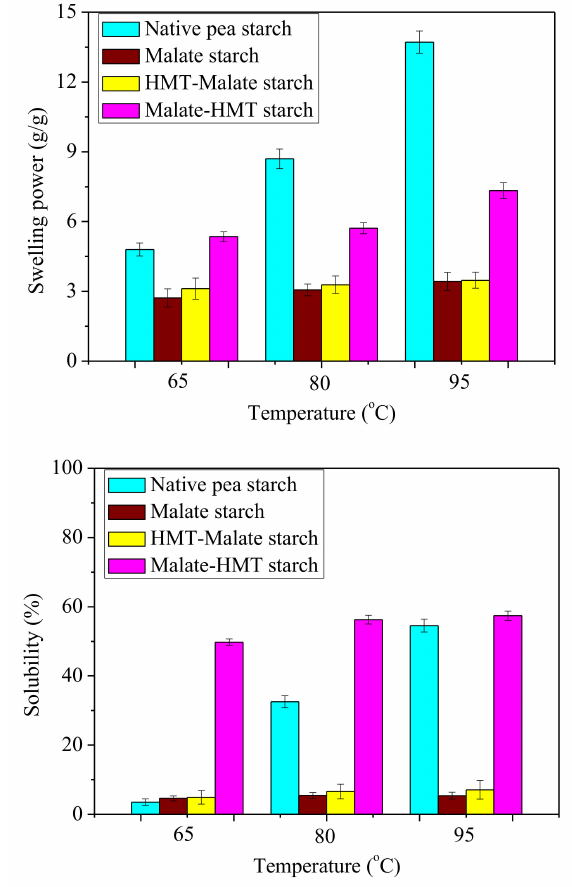
Figure 2. Swelling power and solubility of malate starch